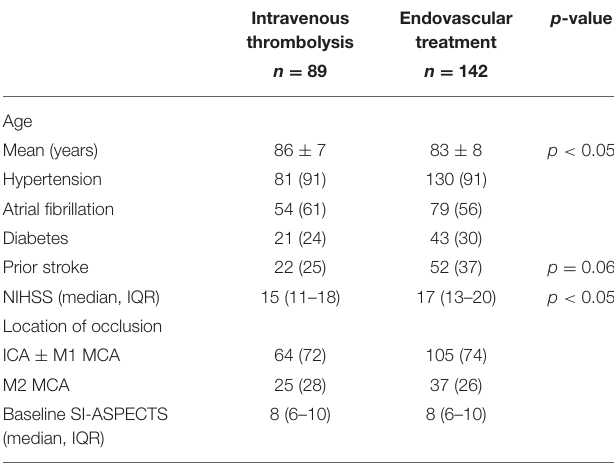
TABLE 2 | Clinical characteristics of previously dependent stroke patients (mRS ≥ 3) after either thrombolysis or endovascular